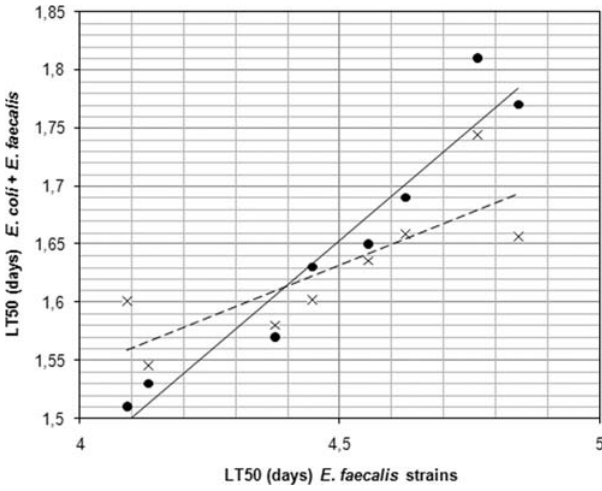
Figure 2. Correlation between virulence of E. faecalis strains alone (expressed by LT50s in days) and in combination with E. coli strains . The linear regression model confirmed a linear relation. Dot corresponds to E. faecalis strains associated with NECS23048; cross corresponds to E. faecalis strains associated with NECS19923. The line and the dotted line established the linear regression of NECS23048 and NECS19923, respectively.